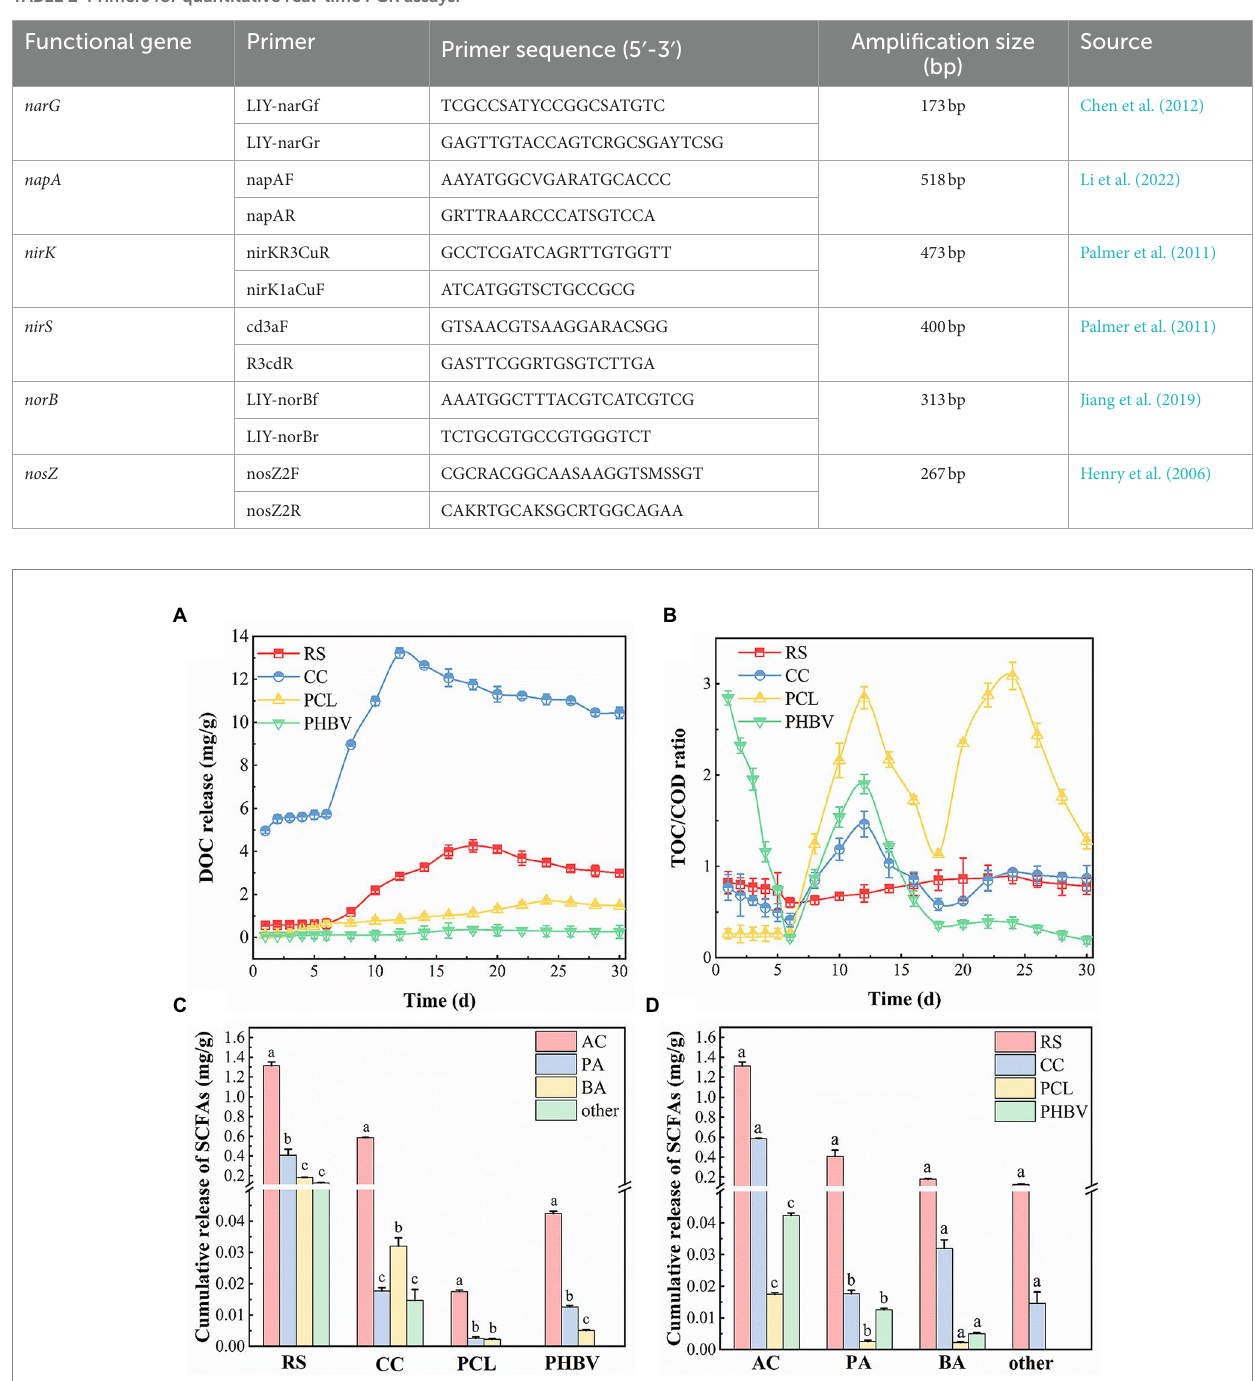
FIGURE 2 Release of different carbon sources. (A) Dissolved organic carbon (DOC); (B) Total organic carbon/Chemical oxygen demand (TOC/COD); (C) Differences in Short-chain fatty acids (SCFA) of the same carbon source; (D) Cumulative release of same SCFA with different carbon